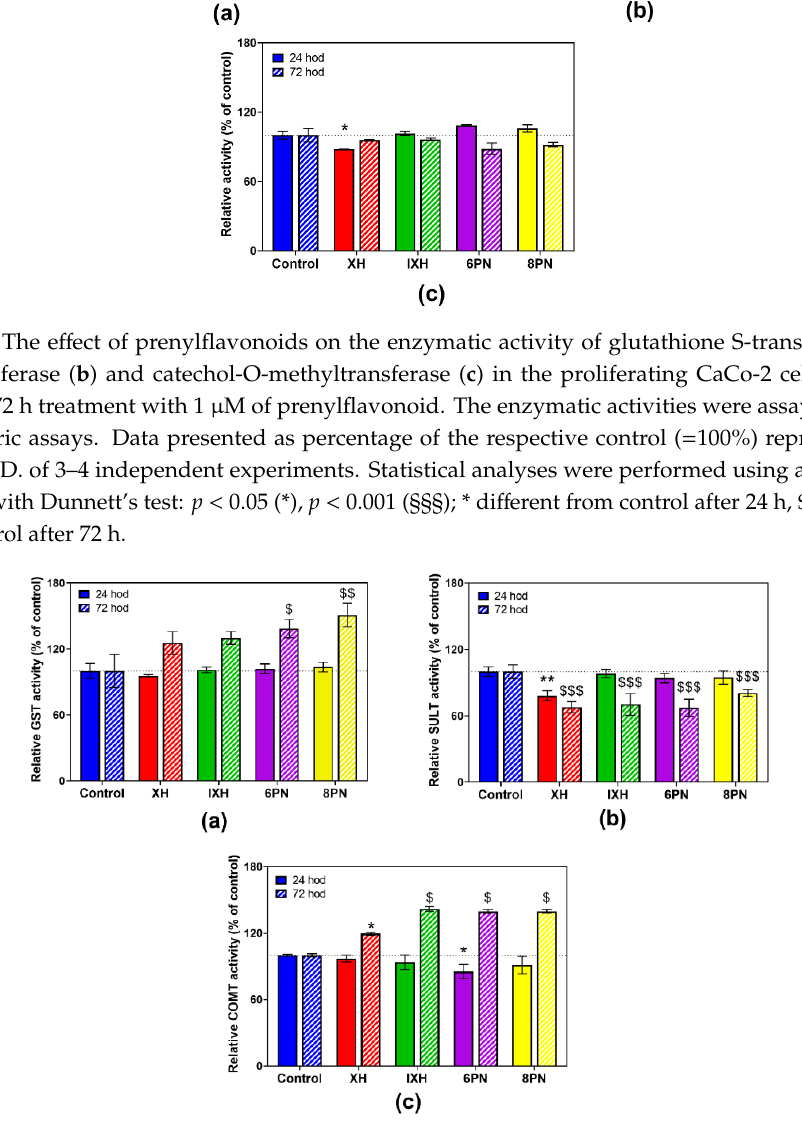
Figure 5. The e ff ect of prenylflavonoids on the enzymatic activity of glutathione S-transferase ( a ), sulfotransferase ( b ) and catechol-O-methyltransferase ( c ) in the di ff erentiated CaCo-2 cells after 24 h and 72 h treatment with 1 µ M of prenylflavonoid. The enzymatic activities were assayed using the colorimetric assays. Data presented as percentage of respective control ( = 100%) represent the mean ± S.D. ( n = 3–4). Statistical analyses were performed using a one-way ANOVA with Dunnett’s test: p < 0.05 (* or §), p < 0.01 (** or §§), p < 0.001 (§§§); * di ff erent from control after 24 h, $ di ff erent from control after 72